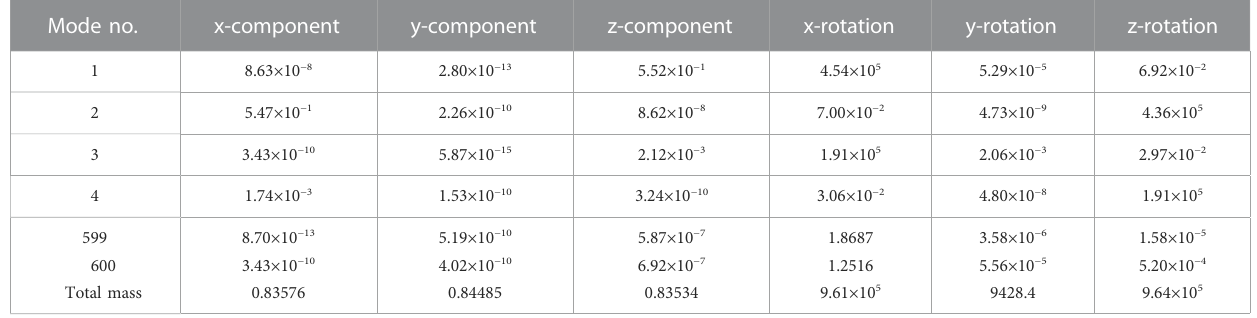
TABLE 2 Effective mass of the energy-absorbing and anti-scouring column. Mode no.